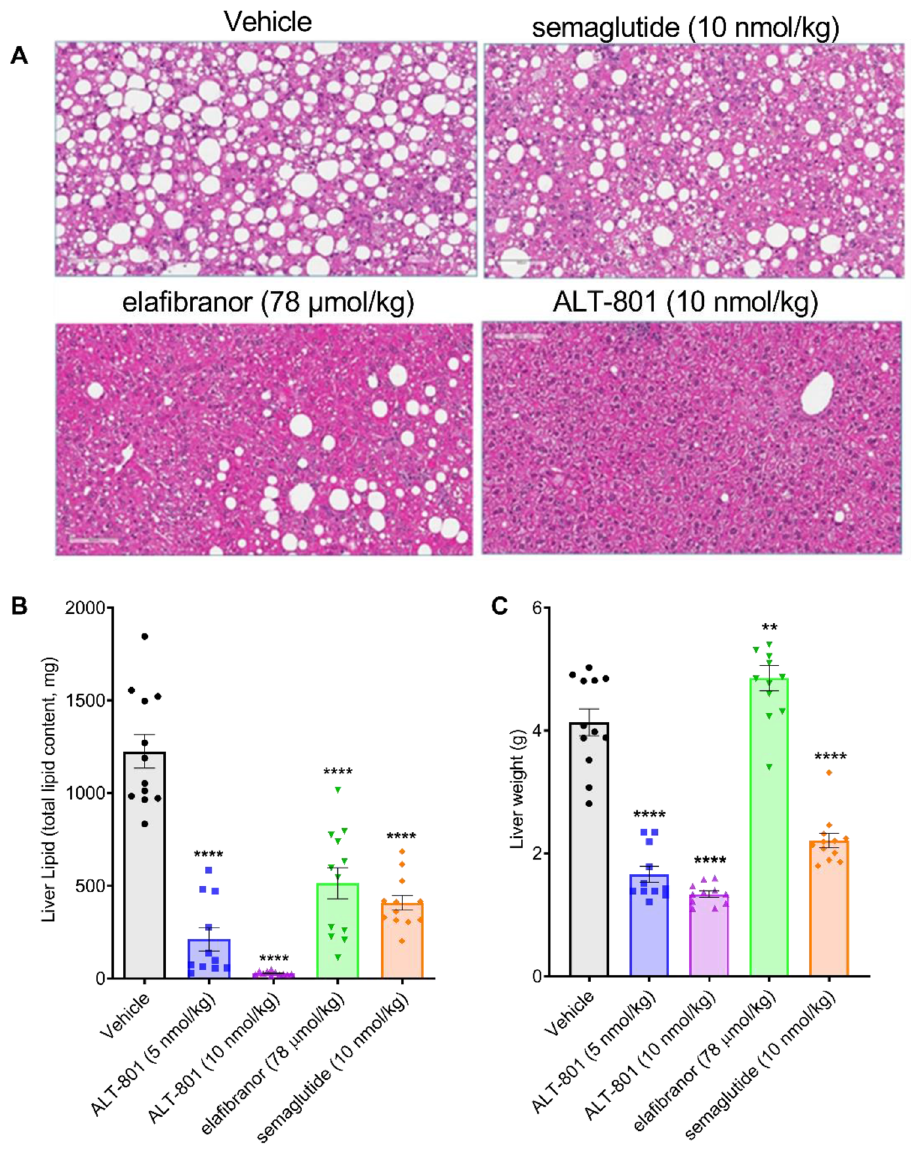
Figure 3. Effects of treatment on liver fat content and liver weight. ( A ) Representative H&E-stained images of liver morphology at the end of treatment period for vehicle, semaglutide, elafibranor, and ALT-801 10 nmol/ kg treated DIO-NASH animals (magnification 20×, scale bar = 100 µm). ( B ) Mean total liver fat content (mg). ( C ) Mean terminal liver weight (g). Data are expressed as mean ± SEM (n = 11–12). ** p < 0.01, **** p < 0.0001 vs. vehicle